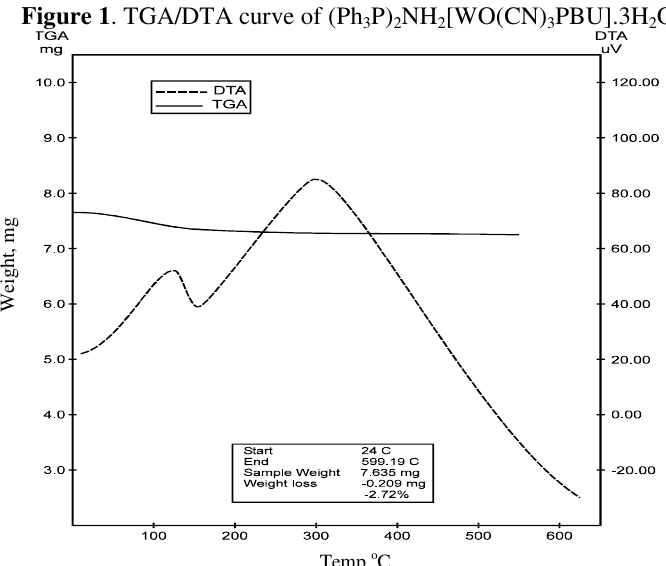
Figure 2 . TGA/DTA curve of Cs[WO(CN)